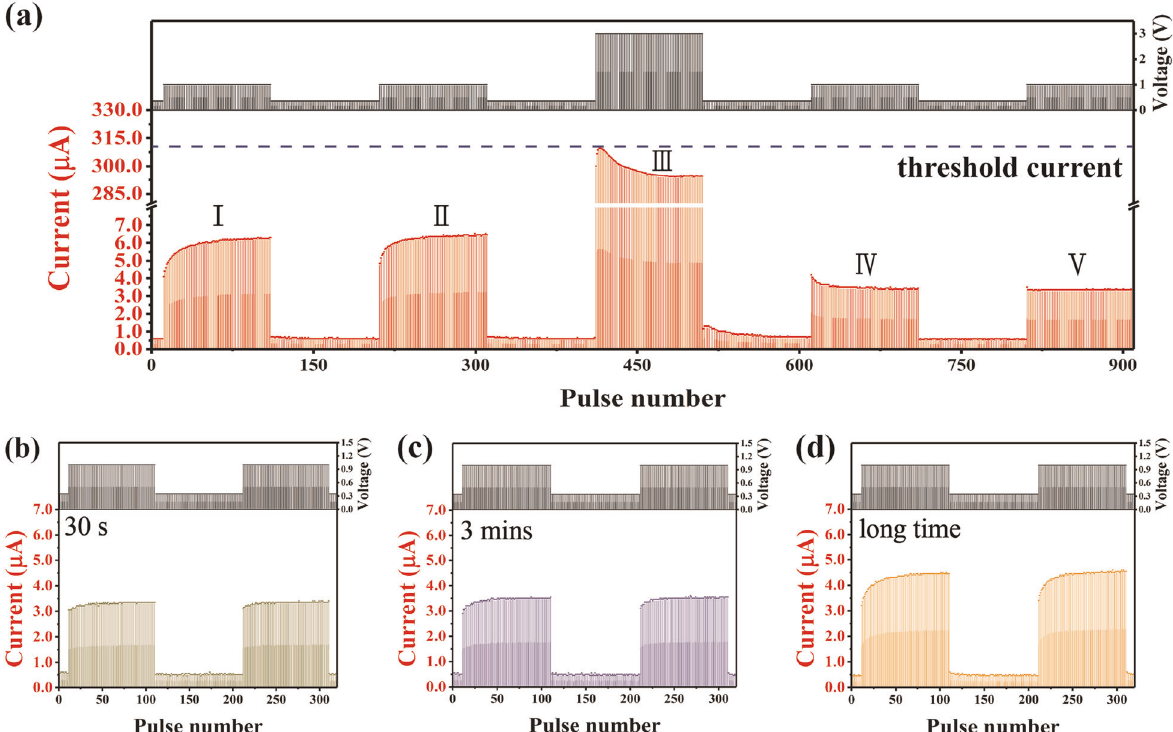
Fig. 6 Emulation of the nerve injuries by mild and severe stimuli. a Response of the post-synaptic current to severe stimuli. The dash line shows the threshold current for the functional loss of the nerve system. b – d The complete functional loss occurs and complete recovery cannot be achieved for a long